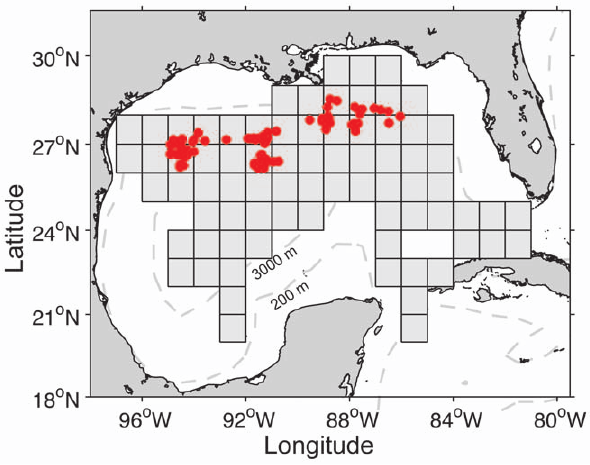
Figure 1. Locations of pelagic longline sets in the Gulf of Mexico. Each grey square indicates where one or more longline sets were recorded by fishery observers on commercial longline vessels (n=2662 sets) within the 1 6 1 u area (we are unable to show locations of individual sets due to privacy concerns). Each red circle indicates a single longline set during our laboratory’s cruises on longline vessels targeting bluefin tuna for tagging (n=112 sets).